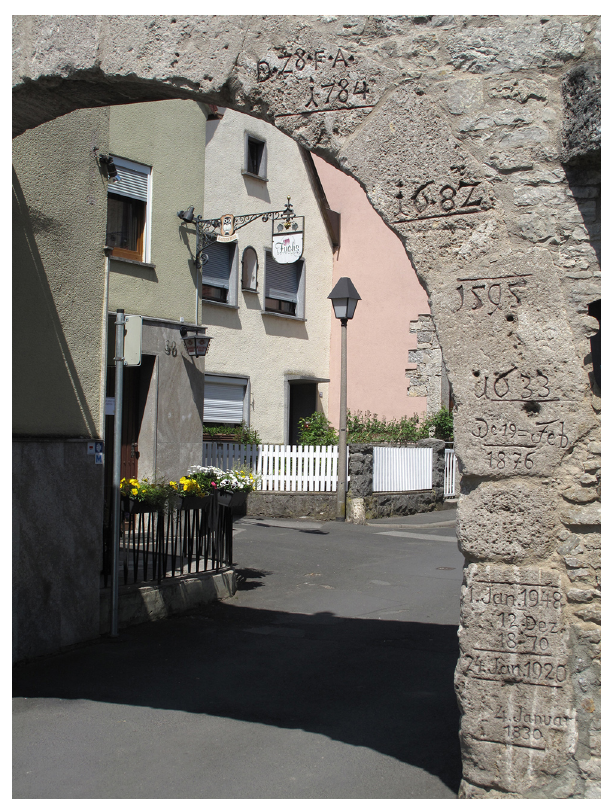
Figure 1. Flood marks of the River Main on the historic city fortifi- cation of Eibelstädt near